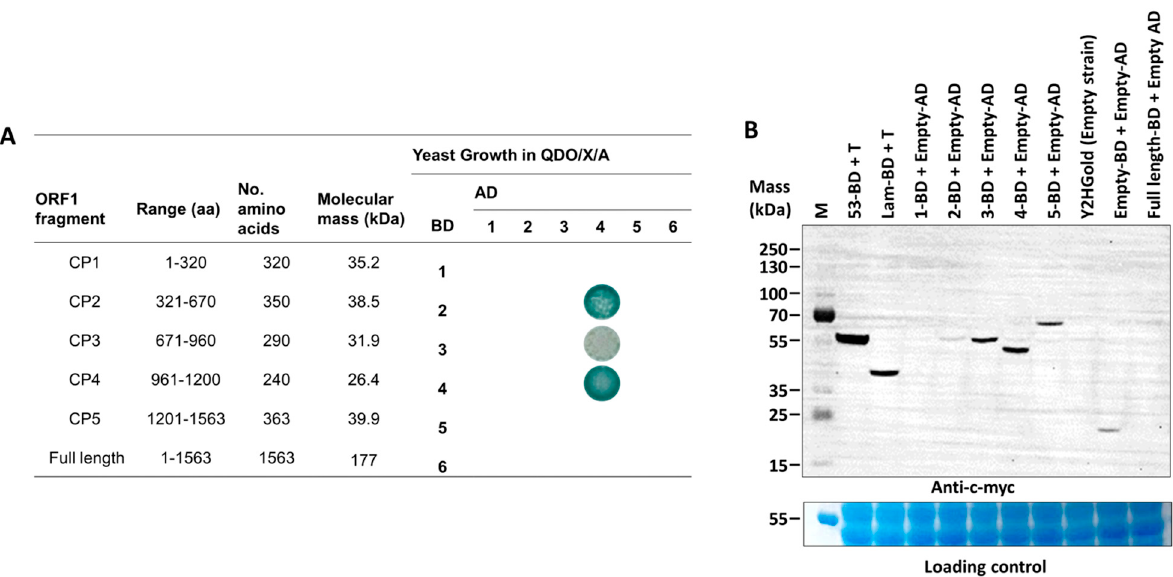
Figure 2. Summary of yeast two-hybrid assays mapping dimerization fragments in the papaya meleira virus (PMeV) ORF1 product, and detection of five fragments of the PMeV ORF1 product. ( A ) Each ORF1 fragment was fused either to the GAL4 binding domain (BD) or GAL4 activation domain (AD) in pDESTGBKT7 and pDESTGADT7, respectively, and transformed in the yeast strain Y2HGold. Positive interactors were selected in QDO/X/A media. ( B ) The c-myc-fused protein expression was verified by SDS-PAGE of yeast crude protein extracts and Western blotting using an anti-c-myc antibody. The 1- to 5-BD represents each fragment of the PMeV ORF1 product fused to GAL4 BD. 53-BD (GAL4 DNA-BD fused with murine p53) and Lam-BD (GAL4 BD fused with Lamin) were used as controls. Untransformed yeast and yeast transformed with pDEST-BGKT7 plasmids were used as the negative control. M: PageRuler Plus prestained protein ladder.